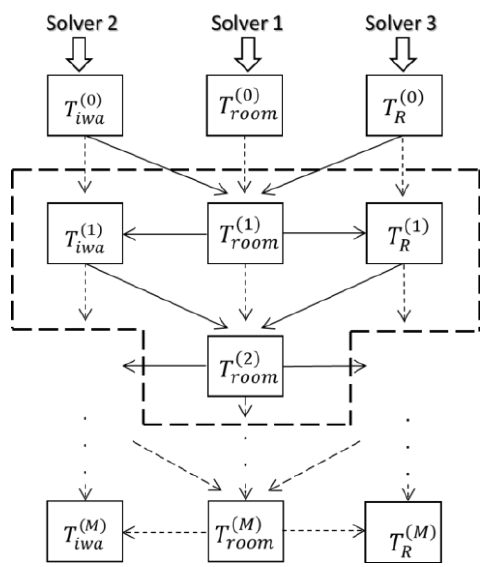
Figure 2. Graphical representation of the explicit coupling procedure.